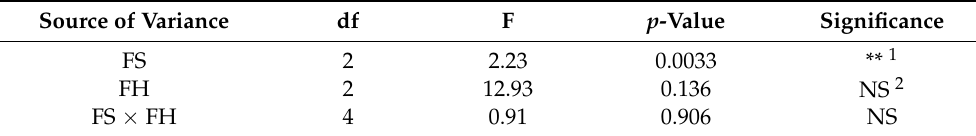
Figure 5. ESW changes under different heights. Note: ESW3, ESW4, and ESW5 represent the ESW when the flight speeds (FS) were 3.0, 4.0 m/s, and 5.0 m/s, respectively. Table 6. Two-way analysis of variance for ESWs. Source of Variance p -Value Significance